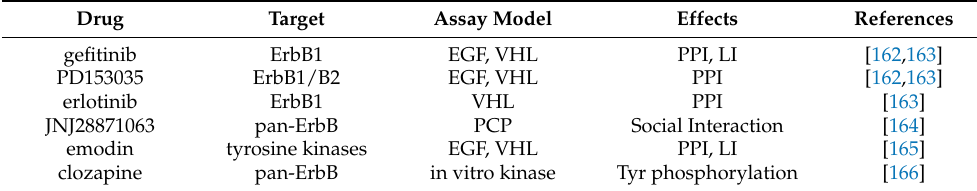
Table 1. Antipsychotic-like effects of drugs acting on ErbB receptor